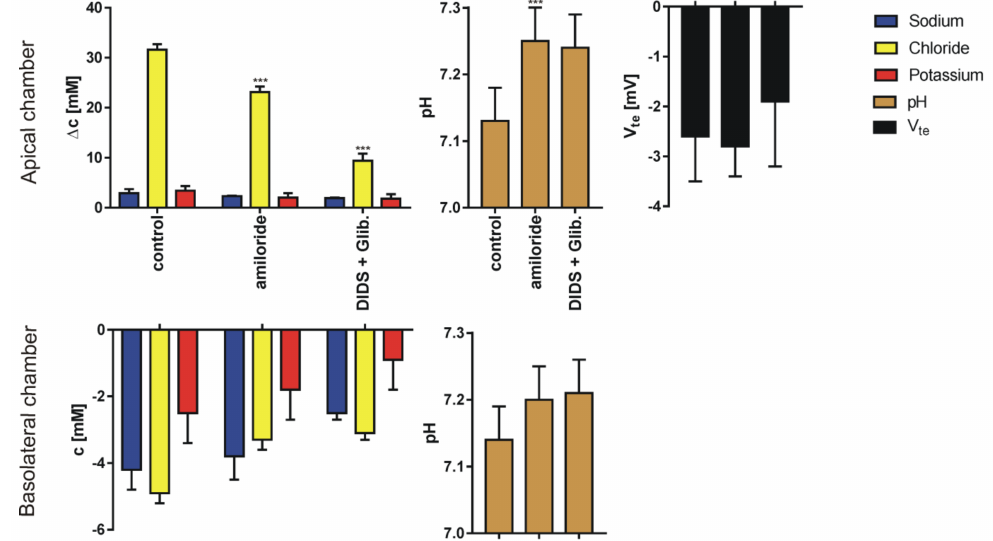
Figure 5. The results (Mean ± SD) of experiments performed in chloride gradient (apical side, KHS3; basolateral side, KHS1) in control conditions and after supplementation of the solution with ion channel blockers. The graph represents: sodium, chloride and potassium transport across epithelial cell monolayer expressed as the concentration change measured 10 min after appropriate solution flow stop; final pH value and the transepithelial potential di ff erence change (N = 15–17 for Cl - , Na + and V te , N = 5 for K + and pH, dependent sample t-test, * p < 0.05, ** p < 0.01, *** p < 0.001). Note di ff erent scales for apical and basolateral